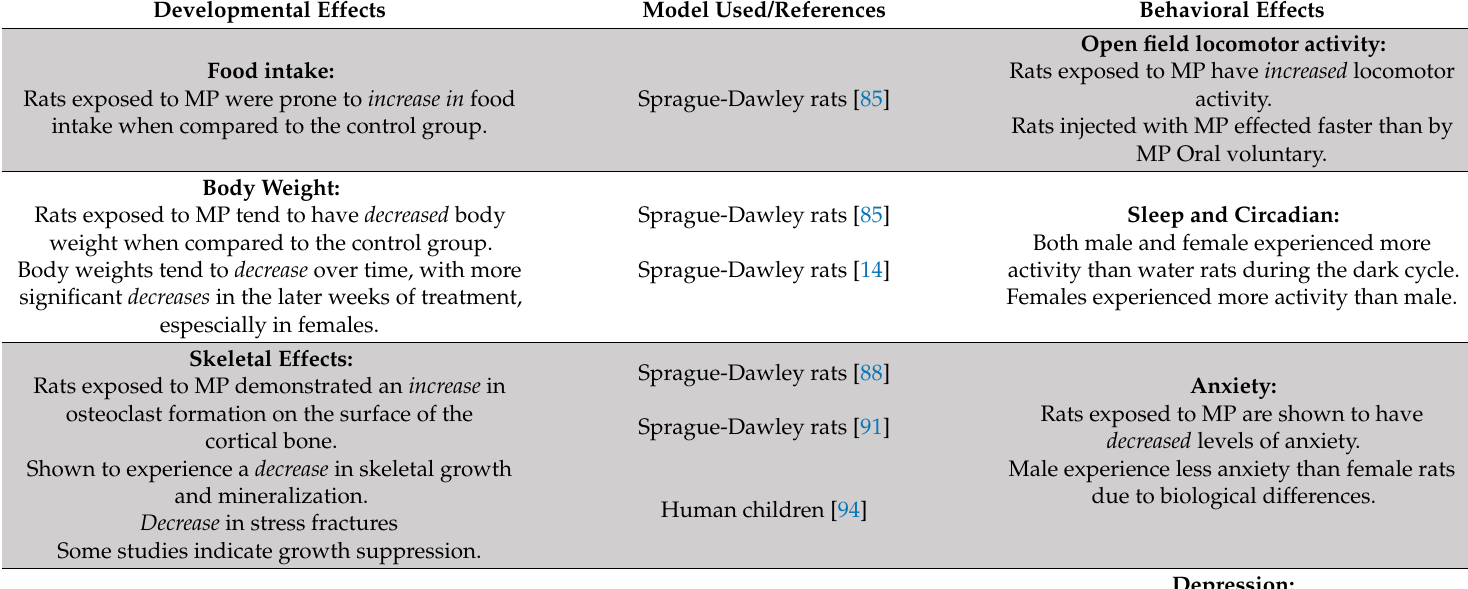
Table 4. Summary of behavioral and developmental effects on oral